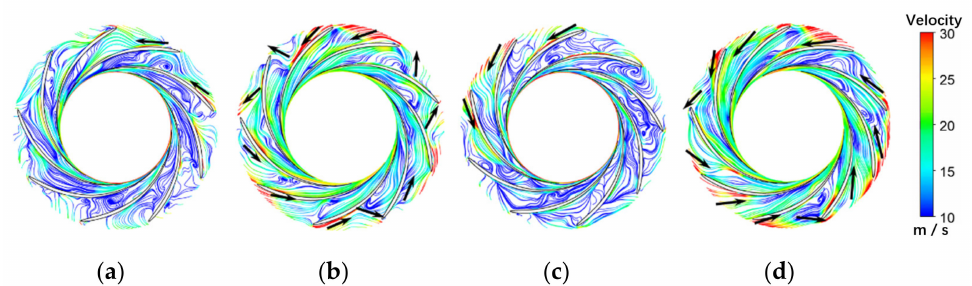
Figure 18. Streamlines in the runner passages at typical times in Case2. ( a ) t = 55 s; ( b ) t = 61 s; ( c ) t = 68 s; ( d ) t = 75 s.